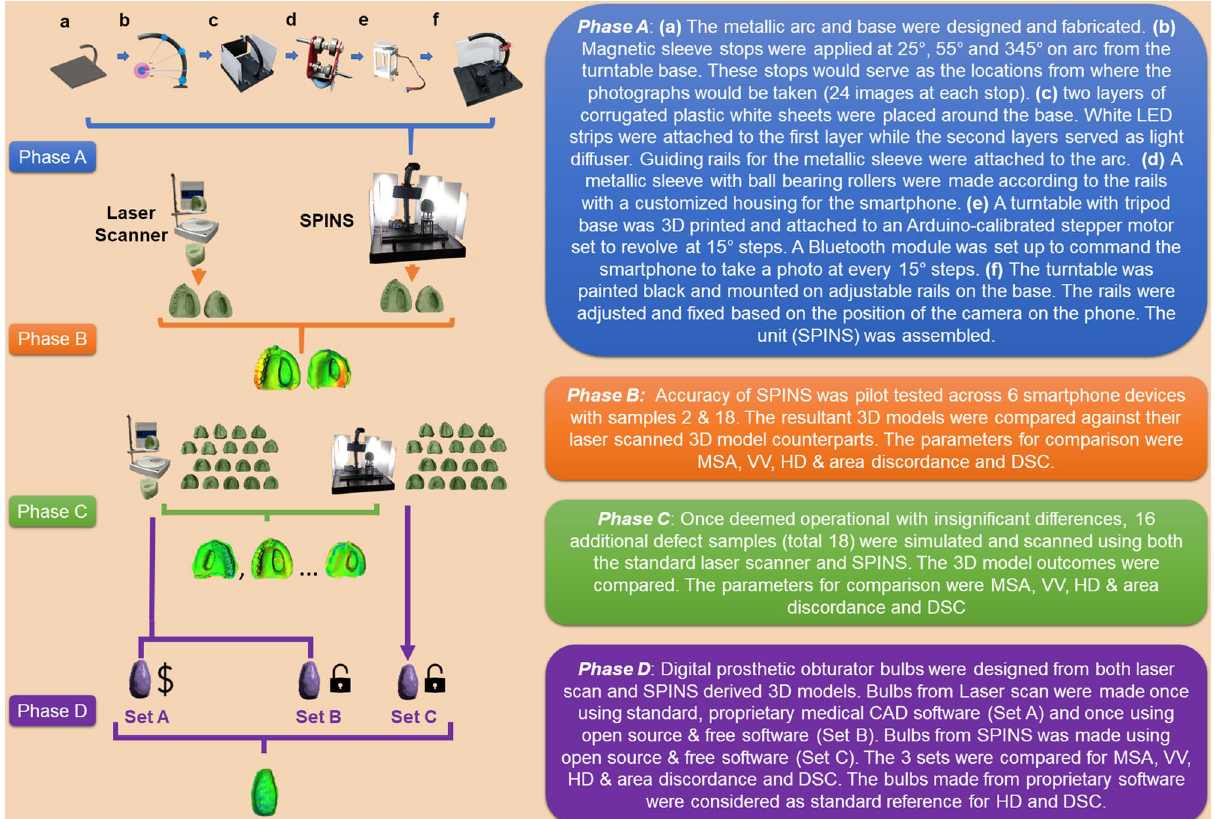
Figure 1. A graphical flowchart summary of the workflow followed in the study. The phases (A–D) and their respective descriptions are colour coded. SPINS smartphone-integrated stereophotogrammetry, MSA mesh surface area, VV virtual volume, HD Hausdorff’s distance, DSC dice similarity